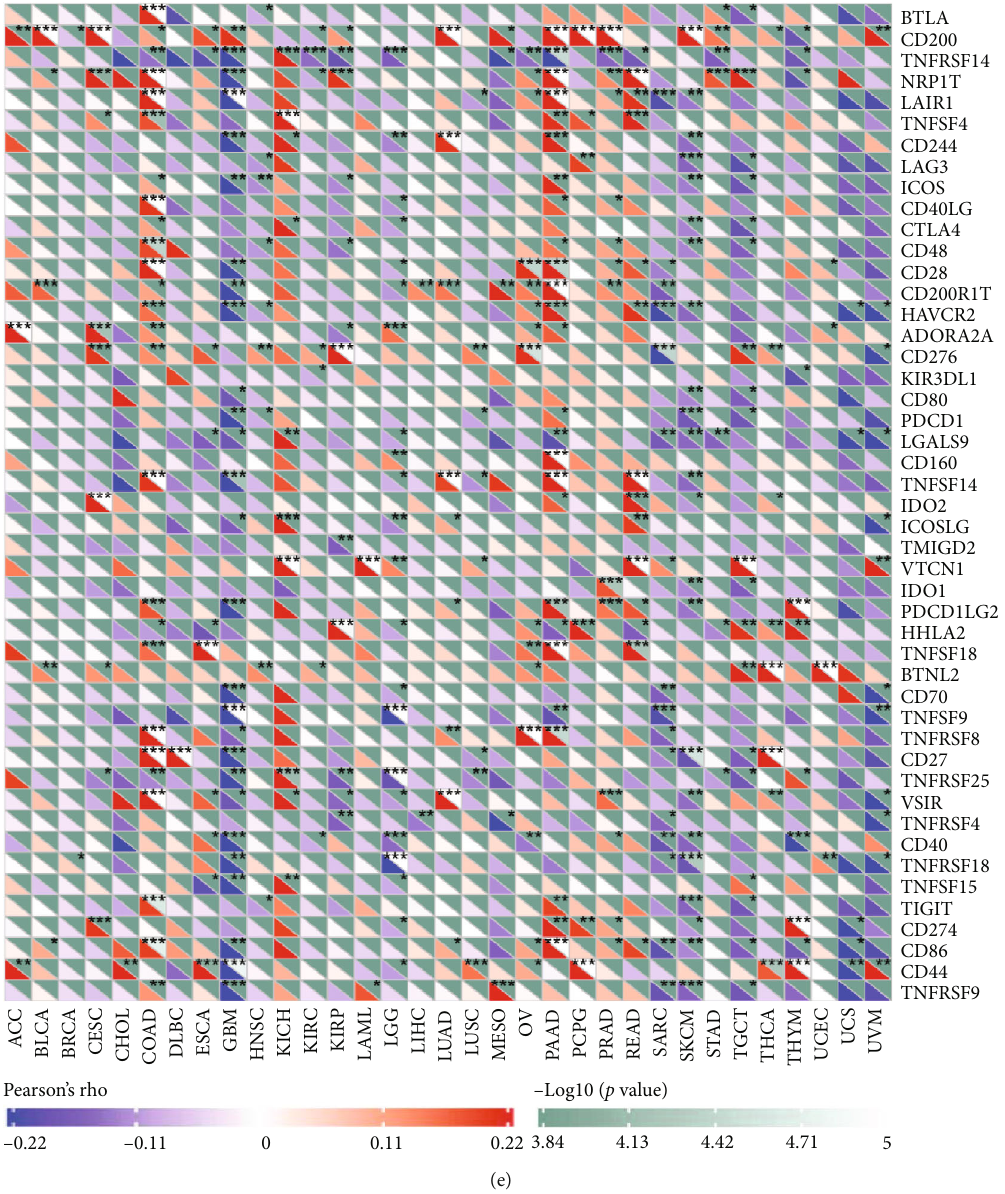
Figure 6: BCHE expression associated with the immune system and tumor microenvironment. (a) Correlations between BCHE expression and immune in fi ltration levels. (b) The varied proportions of 24 subtypes of immune cells in high and low BCHE expression groups in tumor samples. (c) Heatmap of 24 immune in fi ltration cells in tumor samples. (d) Relationships between BCHE and the immune microenvironment in EC. (e) Coexpression analysis of BCHE and immune checkpoint molecules in